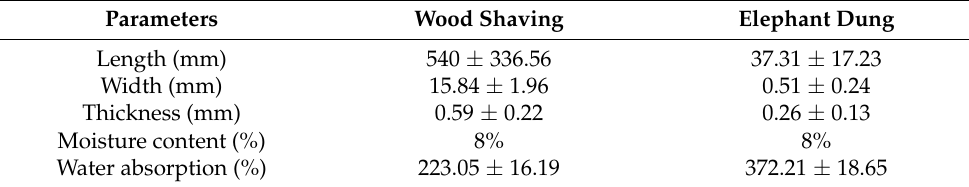
Table 1. Size, moisture content, and water absorption capacity of wood shavings and elephant